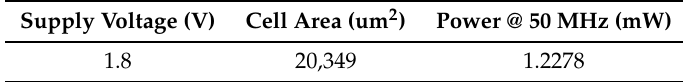
Table 5. Specification of the TSMC 0.18 um process implementation for